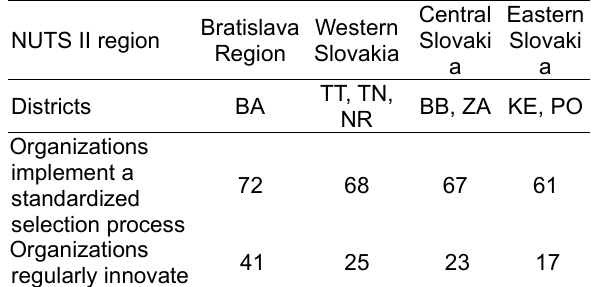
Table 7. Focus of organizations on the